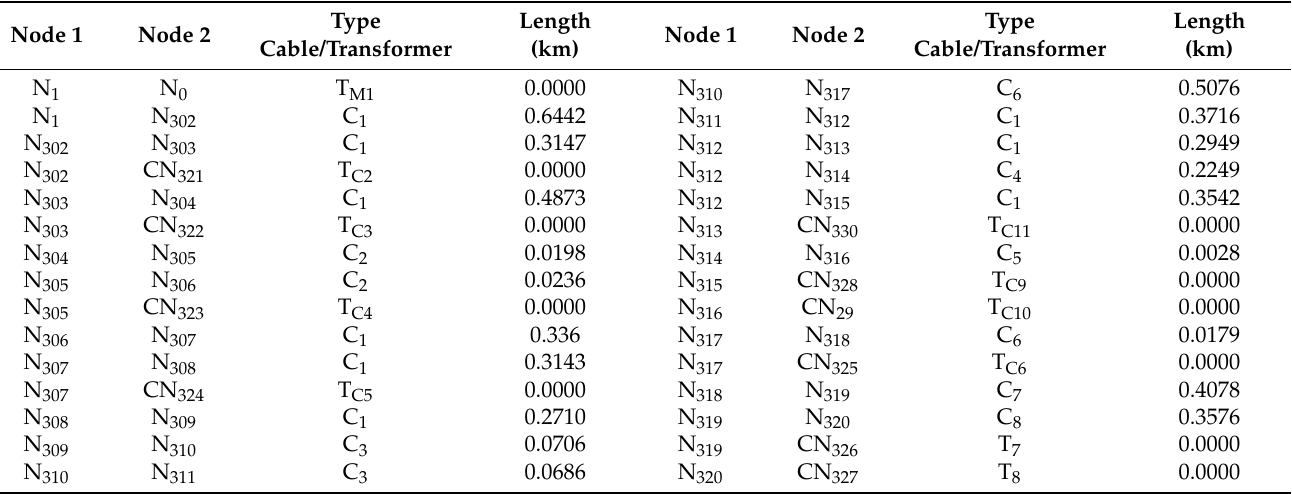
Table 3. Cable length of the medium voltage